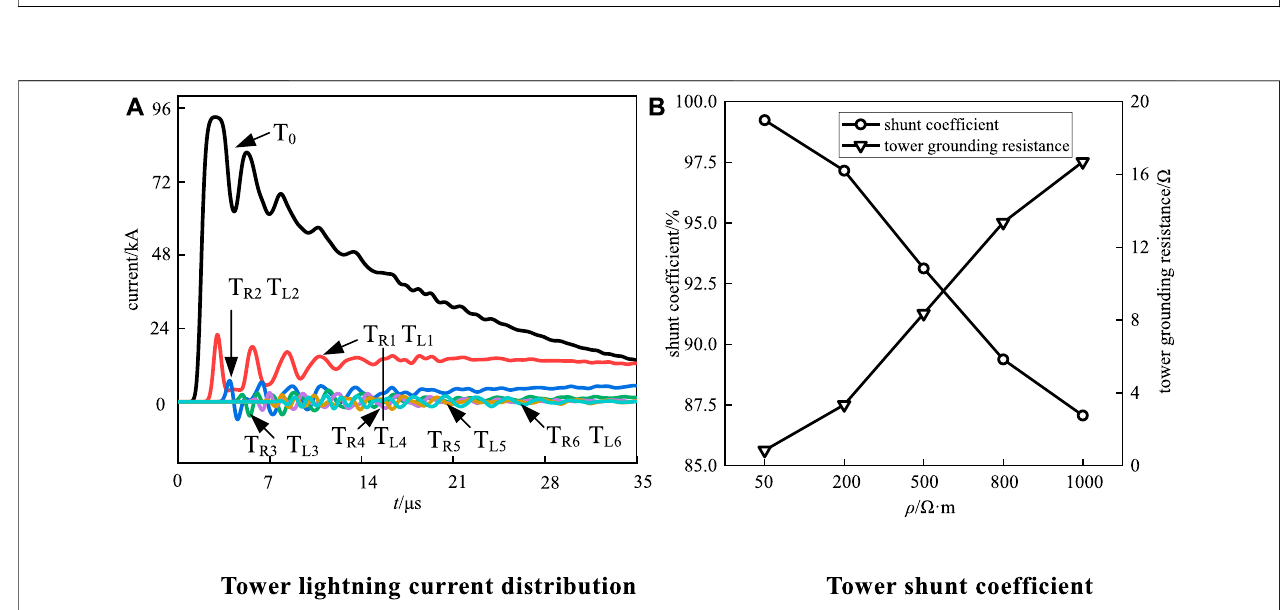
Frontiers in Energy Research |